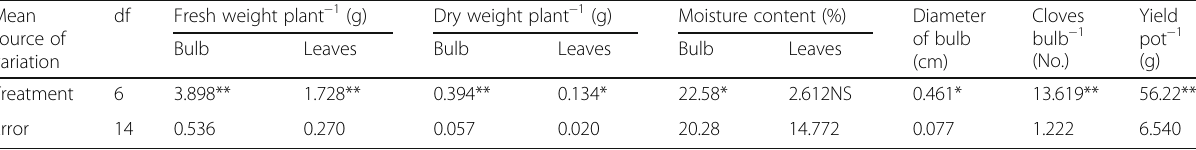
Table 8 Analysis of variance of fresh and dry weight of leaves and bulbs, moisture content, diameter, cloves bulb − 1 and yield of garlic Mean df source of variation